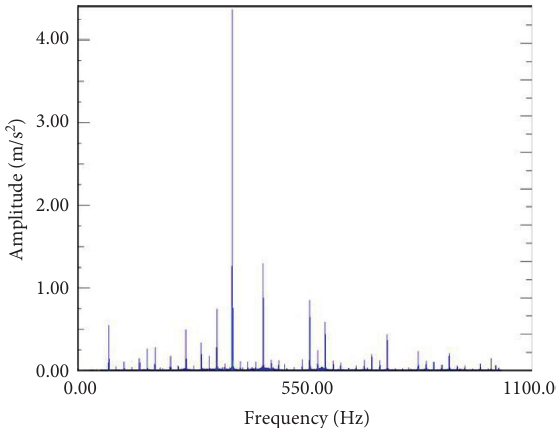
Figure 9: Experimental frequency-domain dynamic response characteristic curves of measuring point 2 in the vertical